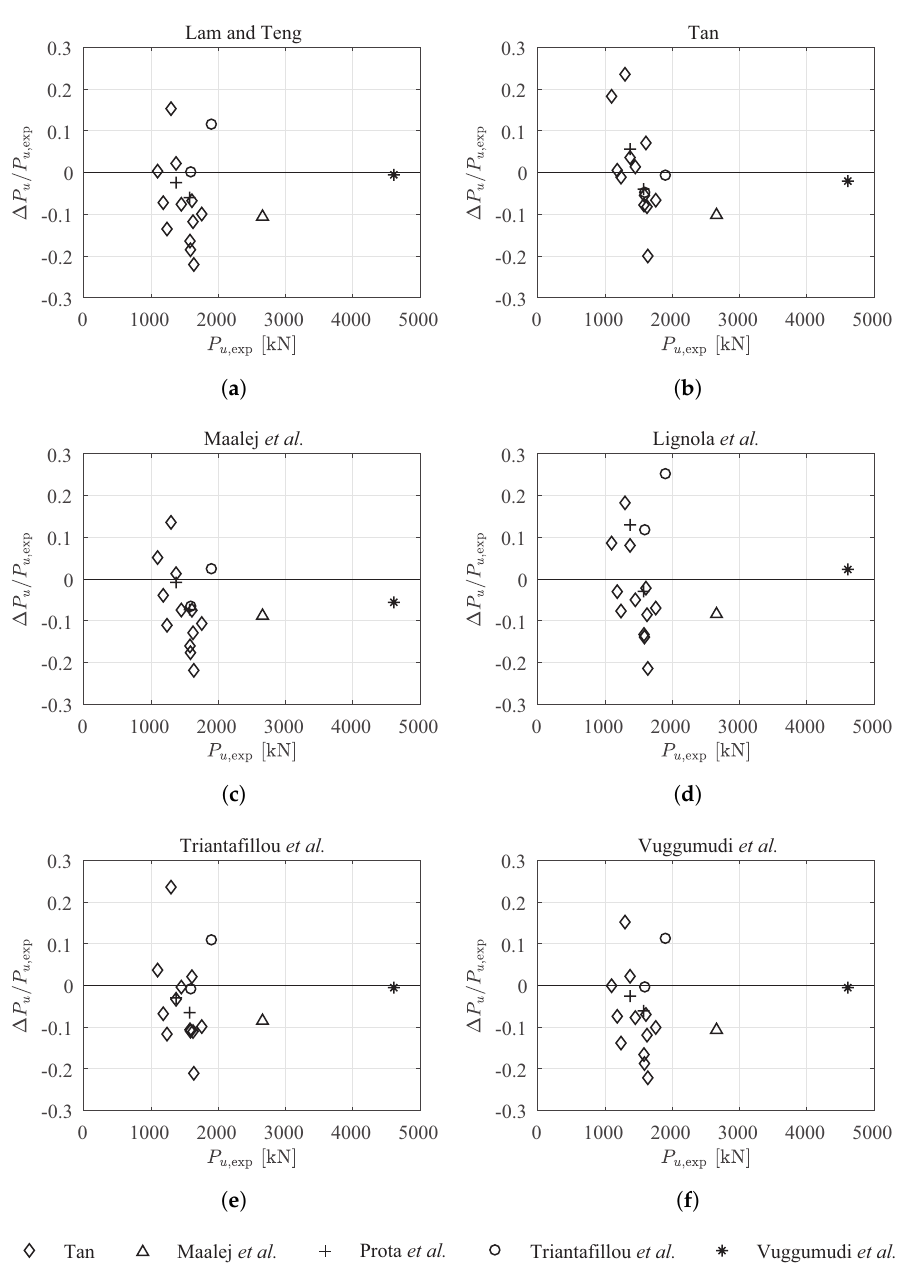
Figure 5. Performance of the analytical models in axial load capacity: error plot diagrams for the analytical model of ( a ) Lam and Teng [10]; ( b ) Tan [20]; ( c ) Maalej et al. [27]; ( d ) Lignola et al. [22]; ( e ) Triantafillou et al. [31]; ( f ) Vuggumudi et al. [32]. Table 3. Performance of the analytical models in axial load capacity: mean value and standard deviation of the percentage error.